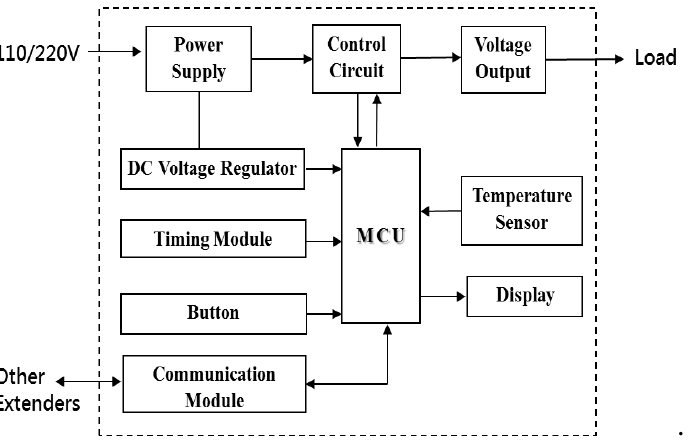
Figure 4. Hardware block diagram of the proposed Internet of Things (IoT)-based temperature control extender. Table 1. Power supply rules for the cooling and heating modes.